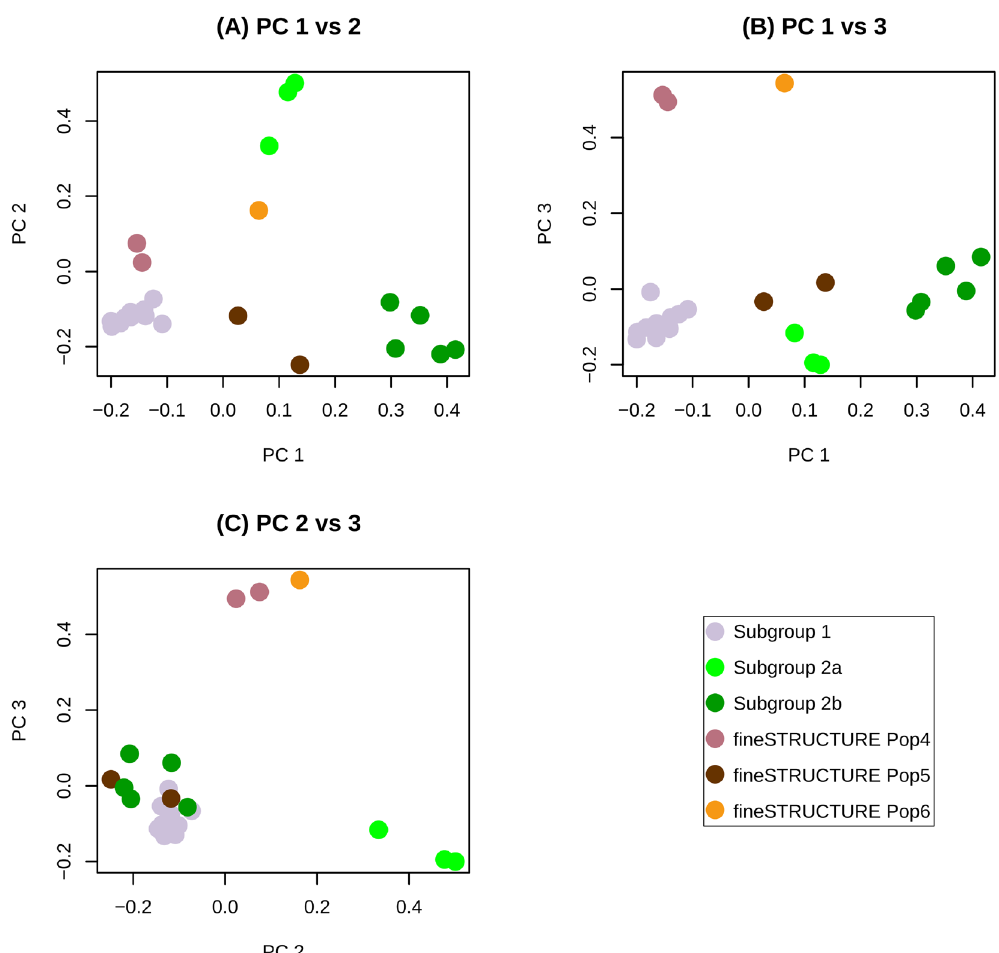
Figure 2. fineSTRUCTURE population assignments of 23 SRLV subtype A2 genomes along the first three principal components. The first three principal components (PCs) account respectively for 40, 18 and 11 percent of the variance in the data. ( A ) PC1 vs PC2, ( B ) PC1 vs PC3 and ( C ) PC2 vs